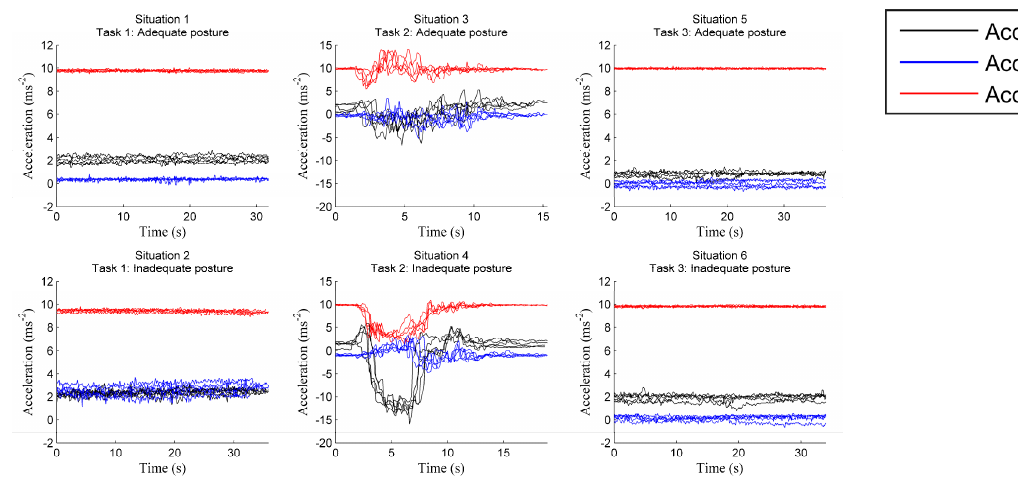
Figure 10. COP’s displacements on the instrumented insole.